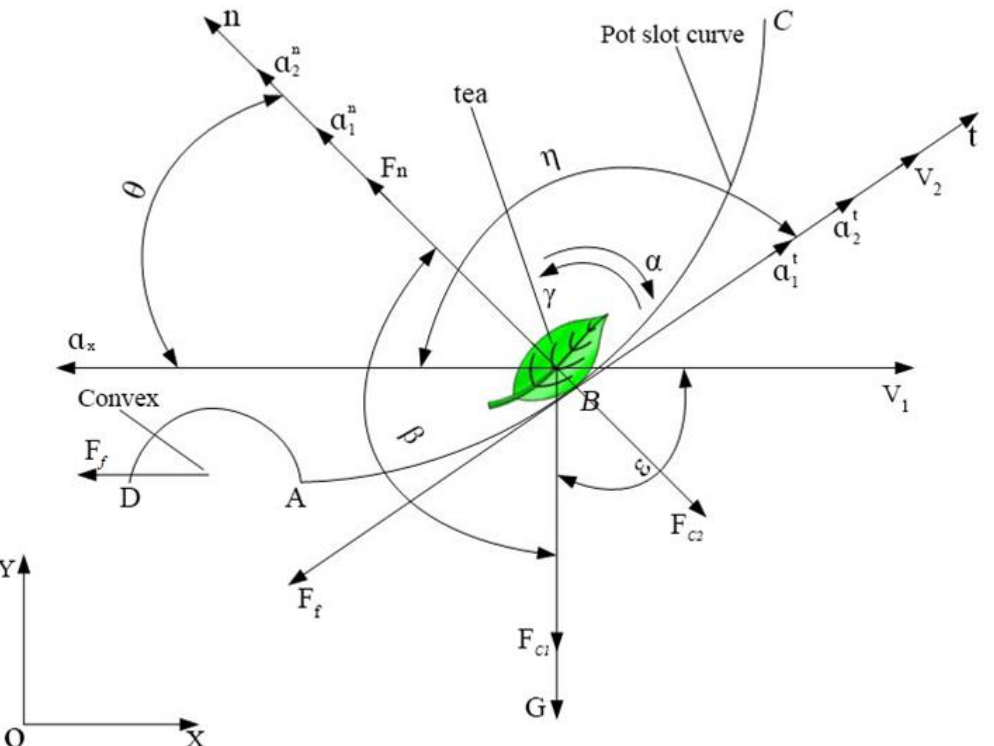
Figure 2. Force analysis diagram of tea particles moving in the